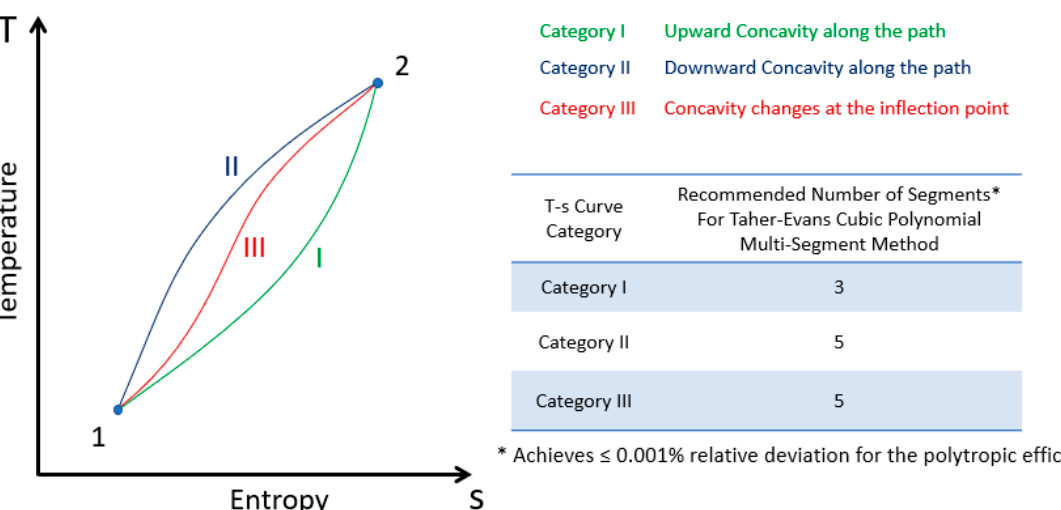
Figure 10. Three different categories are identified based upon polytropic compression path shapes on the T-s diagram. The number of cubic polynomial segments required to achieve ≤ 0.001% relative deviation for the polytropic efficiency is shown.